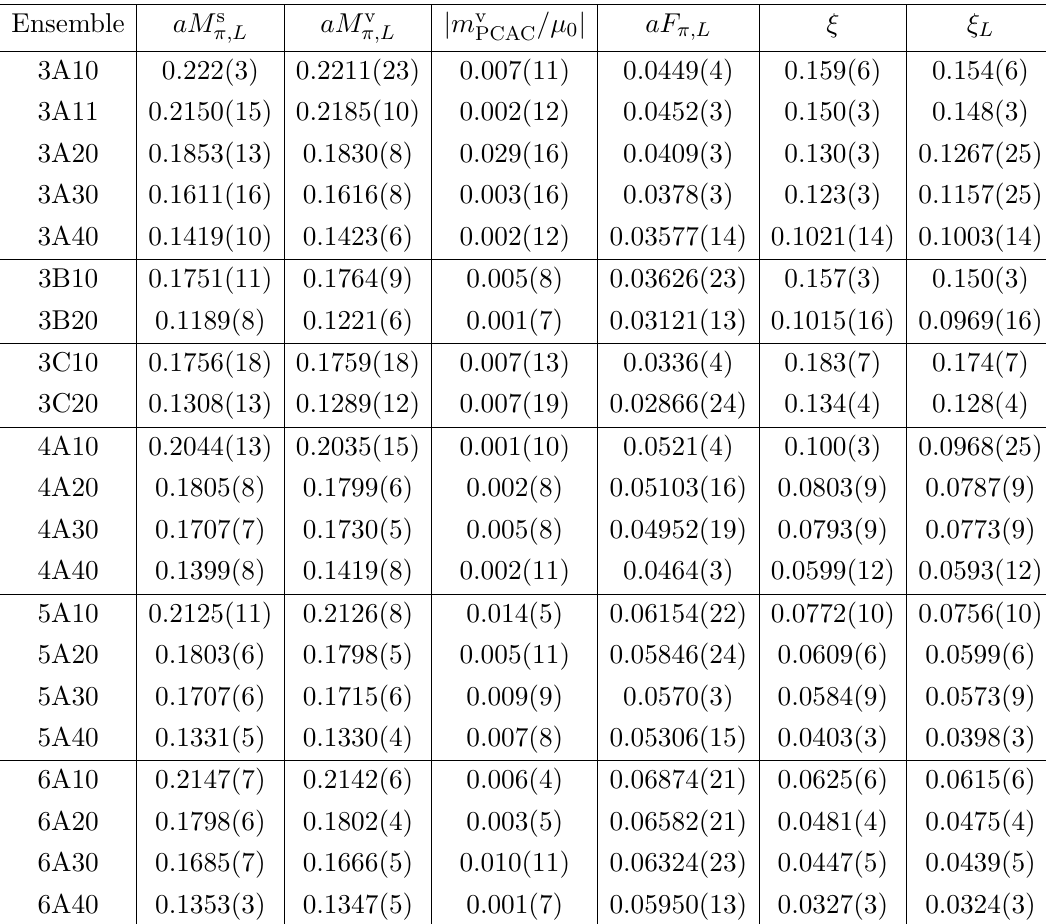
and M v , respectively), π π